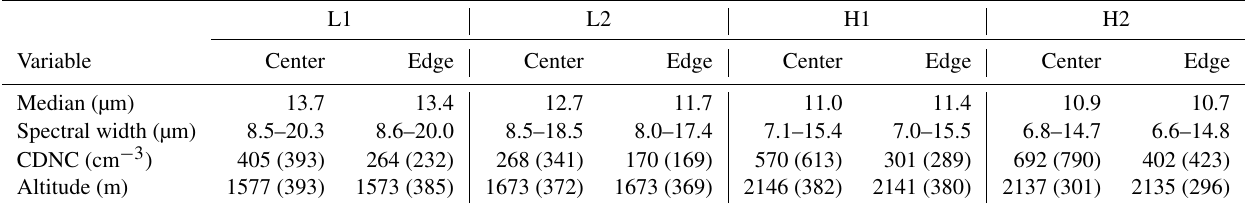
Table 11. Provides the median value and spectral width (10th to 90th percent quantile range) of the drop size distribution, the altitude at which measurements occurred, and the cloud droplet number concentration (CDNC) for both the center and edge zone of cloud passages for each of L1, L2, H1, and H2. Standard deviation values are given in parenthesis. L1 L2 H1